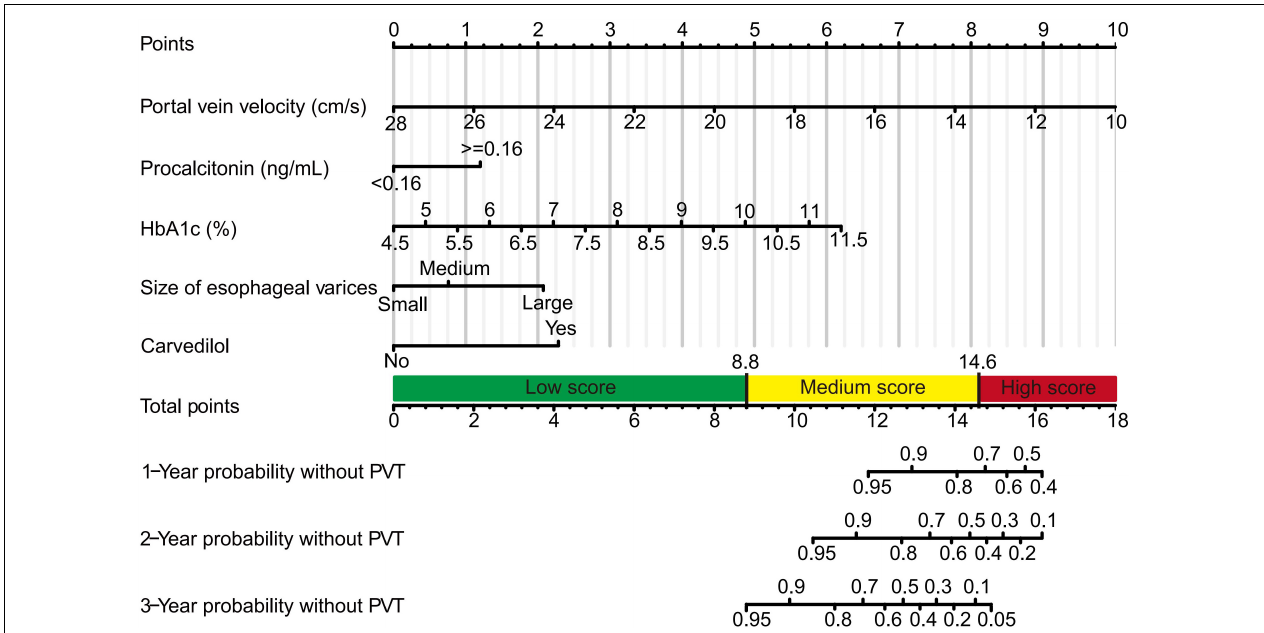
FIGURE 2 | Nomogram predicting PVT in cirrhotic patients during primary prophylaxis for variceal hemorrhage. Five lines were firstly drawn upward to determine the points of the five predictors in the nomogram. The sum of these points was located on the “Total points” axis. Then, a line was drawn downward to determine the possibility of 1-, 2-, and 3-year probability without